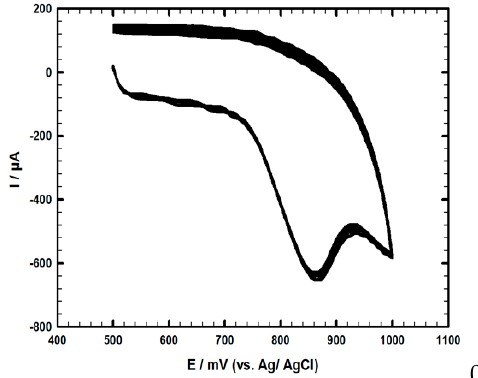
Figure 6. Repeated cycle stability of 1 mmol·L − 1 TZ/0.1 mol·L − 1 PBS/pH 7.40 at ILCCPE…SDS, 25 repeated cycles, scan rate 50 mV·s − 1 .